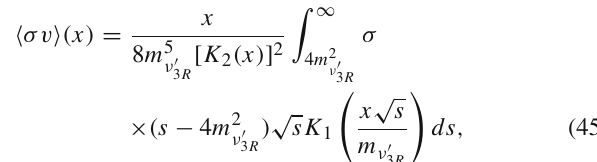
Fig. 4 The DM relic abundance as a function of the DM mass for various values of t . The green band refers to the range of the observed DM relic abundance 0 . 1183 ≤ (cid:18) DM h 2 ≤ 0 . 1213. Left panel: 2 z 1 = z 2 = 1 / 8 and M Z (cid:2) = 4 TeV. Right panel: 2 z 1 = z 2 = 1 / 10 and M Z (cid:2) = 3 . 5